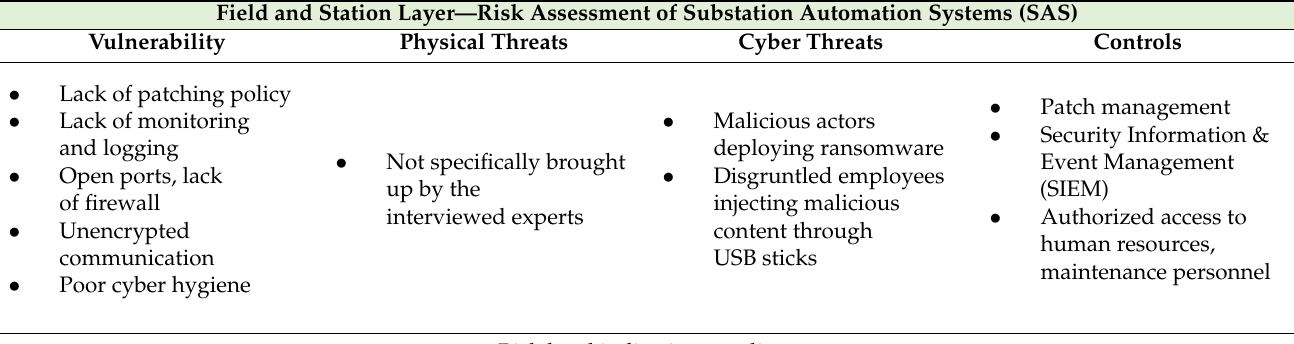
Table 8. Risk analysis of Substation Automation Systems (SAS).